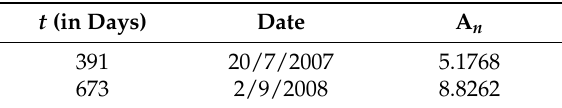
Table 6. Change points in the estimated negative jump time series of NASDAQ index with the corresponding test statistic value.